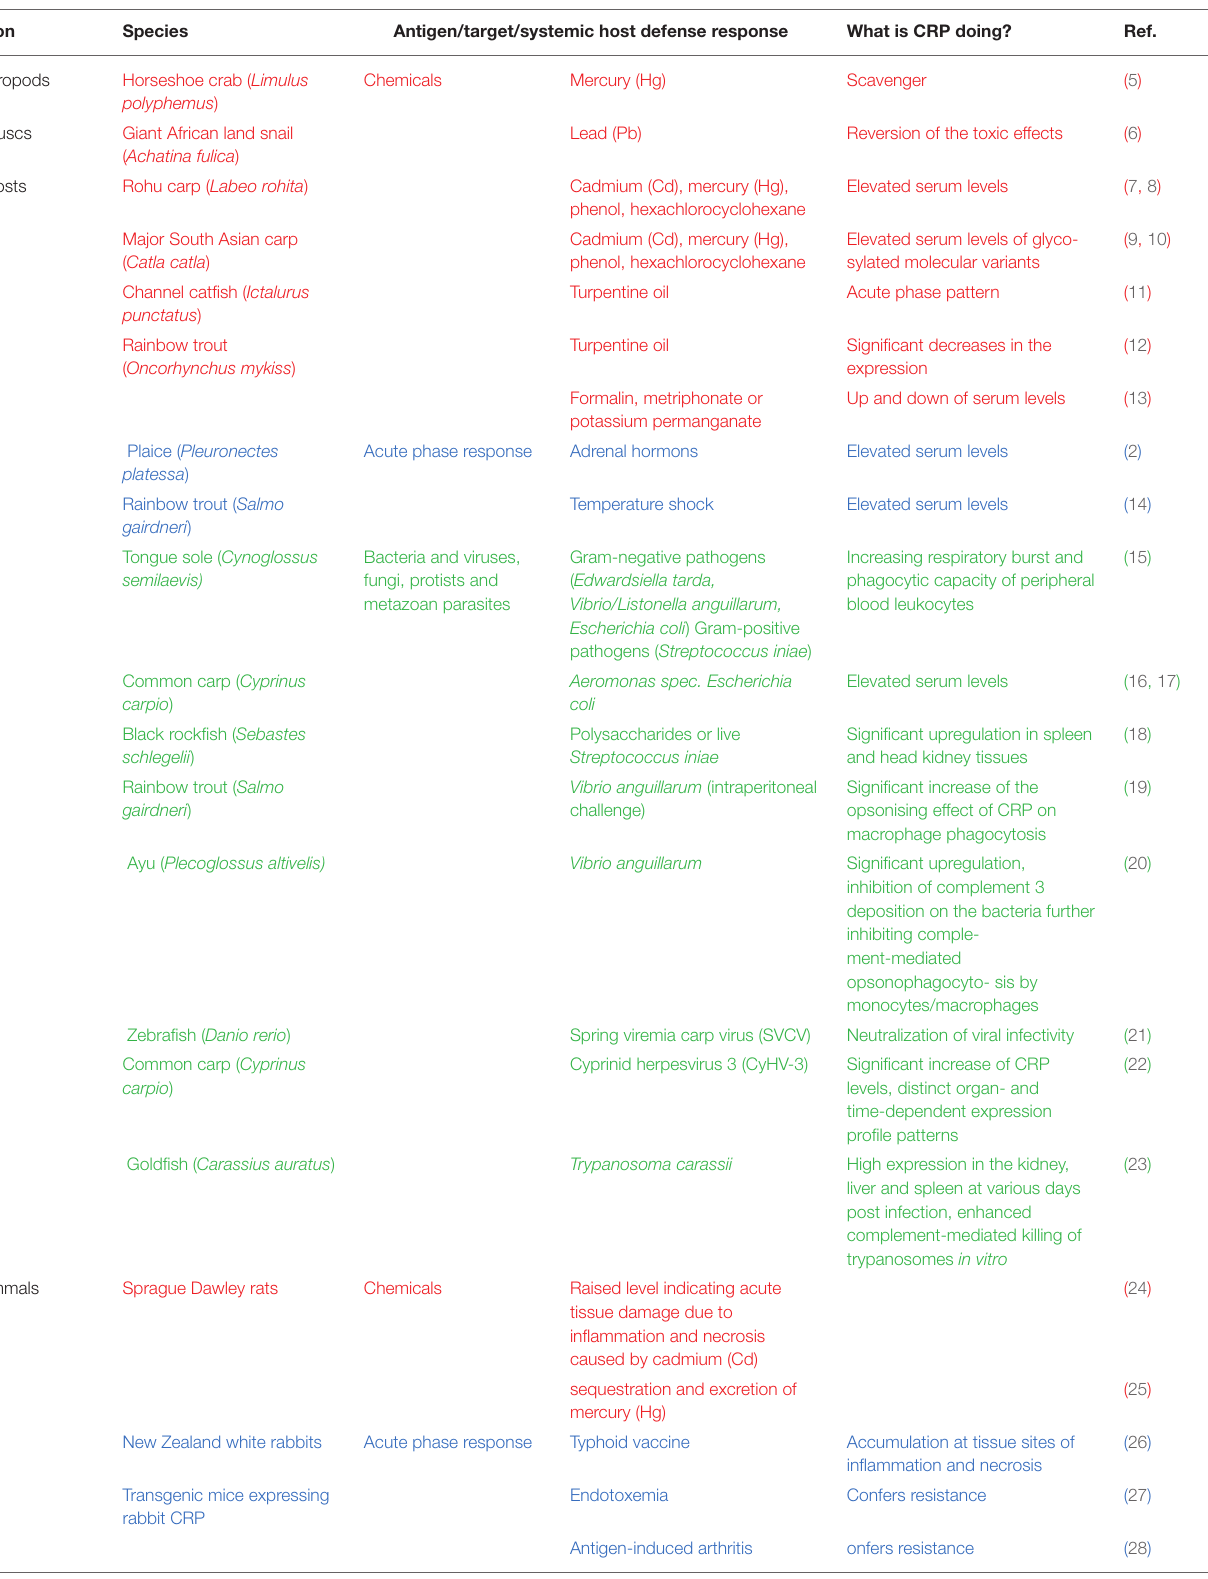
TABLE 1 | Phylogeny of CRP